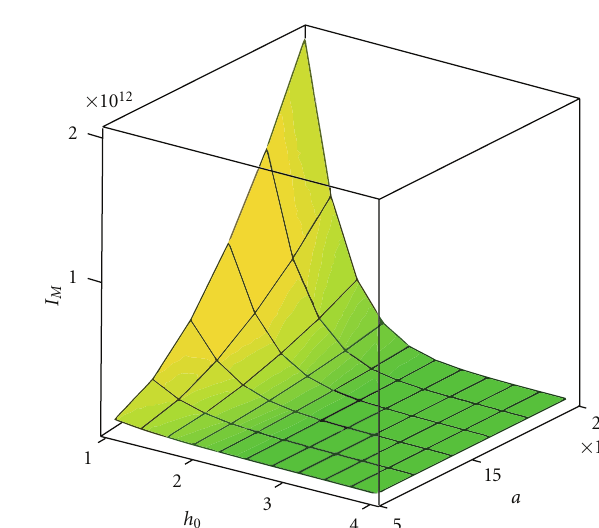
Figure 13: I M ( h 0 , β s ) for m = 2 × 10 − 5 and a = 150000.